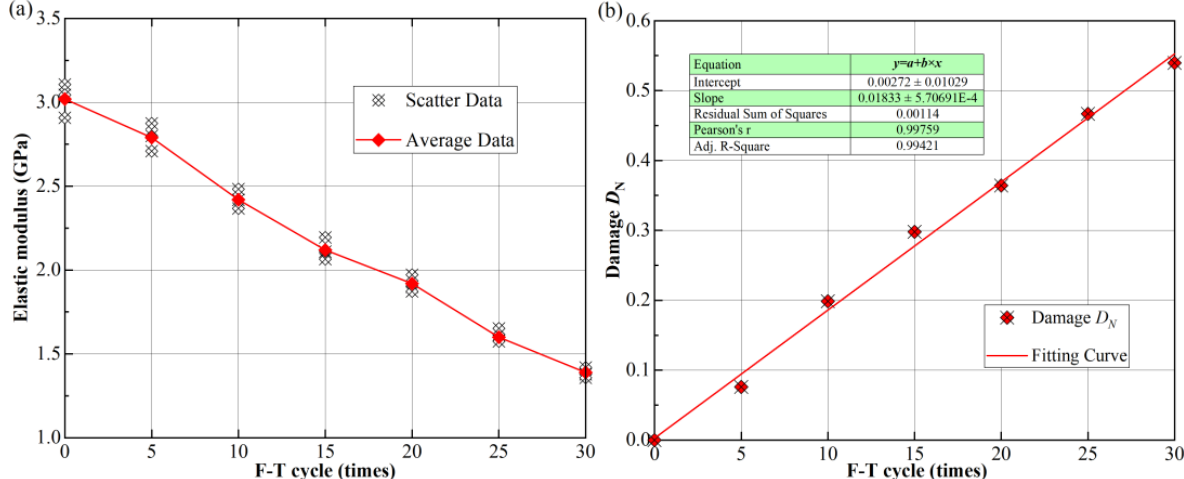
Figure 13. Variation of the elastic modulus ( a ) and damage ( b ) with F-T cycles.